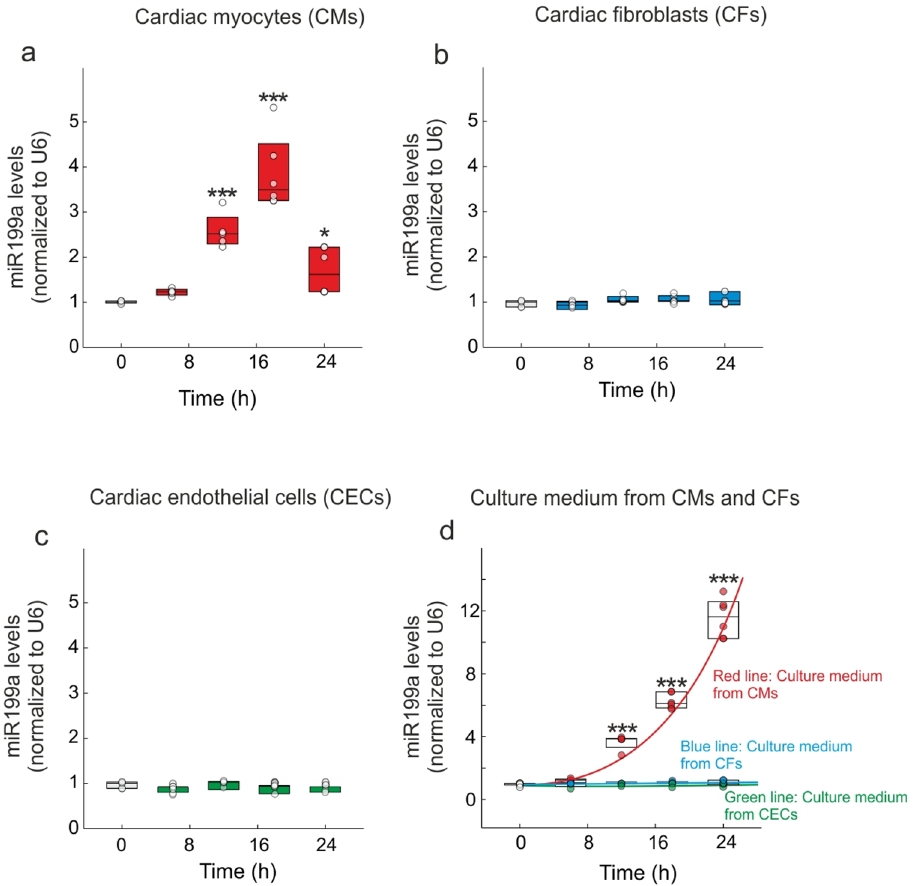
Figure 5. The miR199a-5p is dynamically regulated in CMs after cyclic stretching. ( a ) miR199a levels in CMs after cyclic stretching quantified by RT-qPCR. ( b ) miR199a levels in CFs after cyclic stretching quantified by RT-qPCR. ( c ) miR199a levels in ECs after cyclic stretching quantified by RT-qPCR. ( d ) miR199a levels in the supernatants of CMs (red), CFs (blue) and CECs (green) assessed by RT-qPCR after cyclic stretching. All quantifications derive from n = 10 independent assays/group. All quantitative data are reported as means ± SEM. ***P < 0.001 respect to control assay; determined by two-way ANOVA followed by Bonferroni’s post hoc